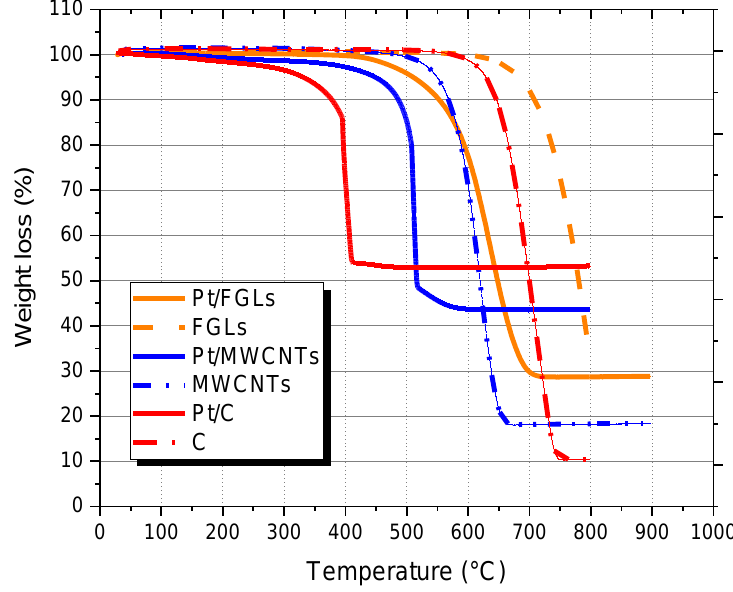
Figure 2. TGA profiles of the samples, in dotted line before Pt deposition and in full line after Pt deposition.